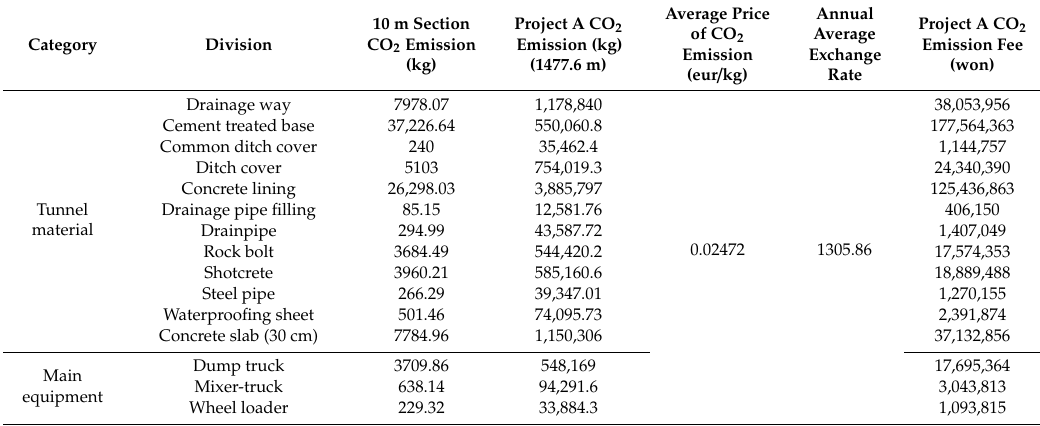
Table 8. Calculation process of CO 2 emission fee during tunnel construction process for Project A.